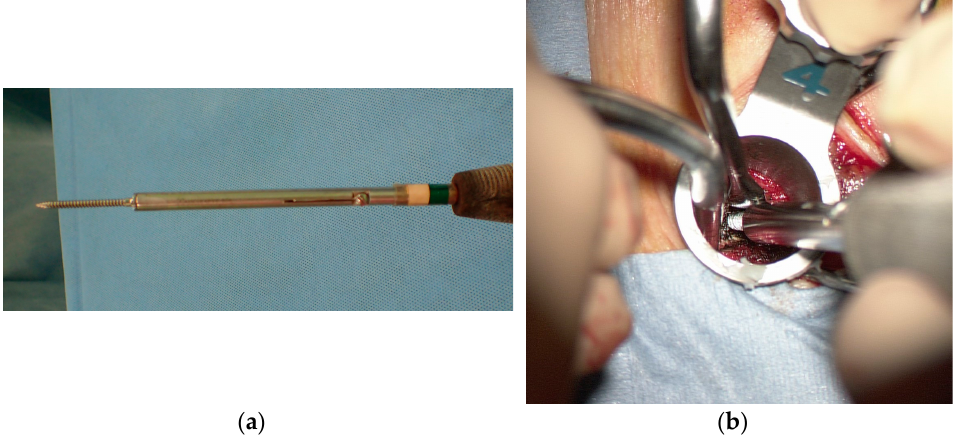
Figure 4. ( a ) A self-drilling pin; ( b ) a self-drilling pin inserted into the pedicle.